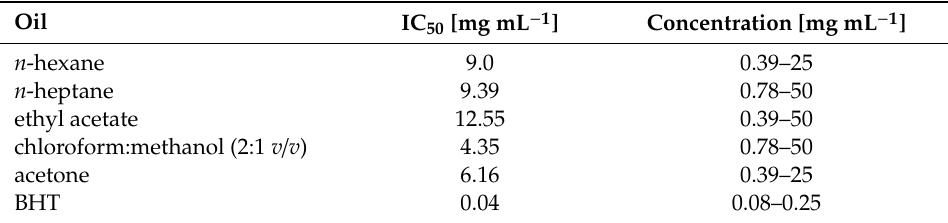
Table 5. Antioxidant activity of the plum seed